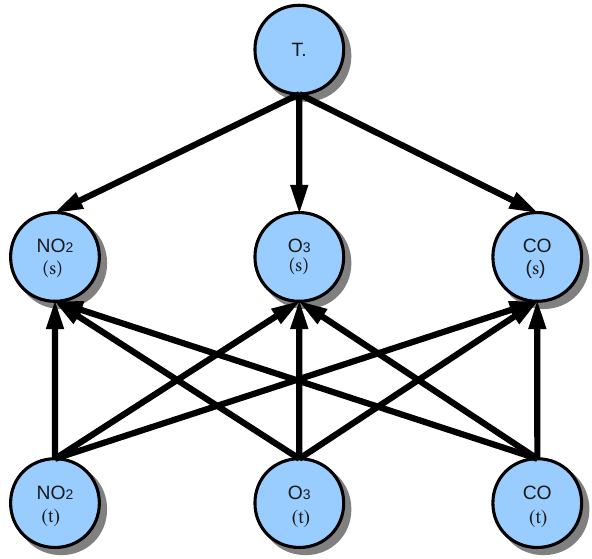
Figure 3. The basic Bayesian network structure for our application. (Symbols with ( s ) are referred to the sensor readings; symbols with ( t ) are referred to the ground truth concentrations.) O 3 ( t ), represents the actual concentration (ground truth) of the corresponding pollutants in the